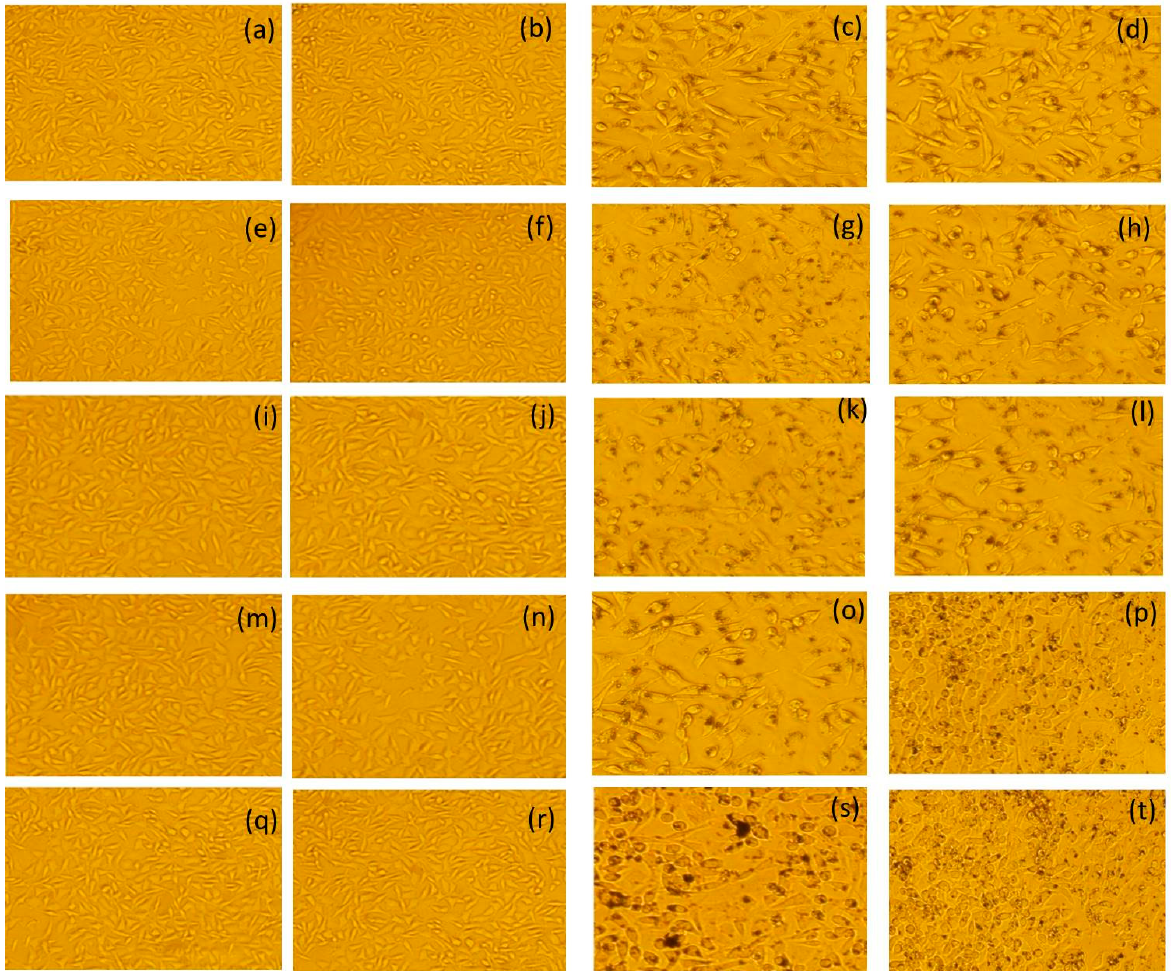
Figure 15. Mouse fibroblast’s cell morphology exposed to control group prepared by water on first day, 15th day, 31st day, 41st day and 51st day, showing normally large, elongated flat cells with cytoplasm ( a , e , i , m , q ). Mouse fibroblast’s cell morphology exposed to experimental group of